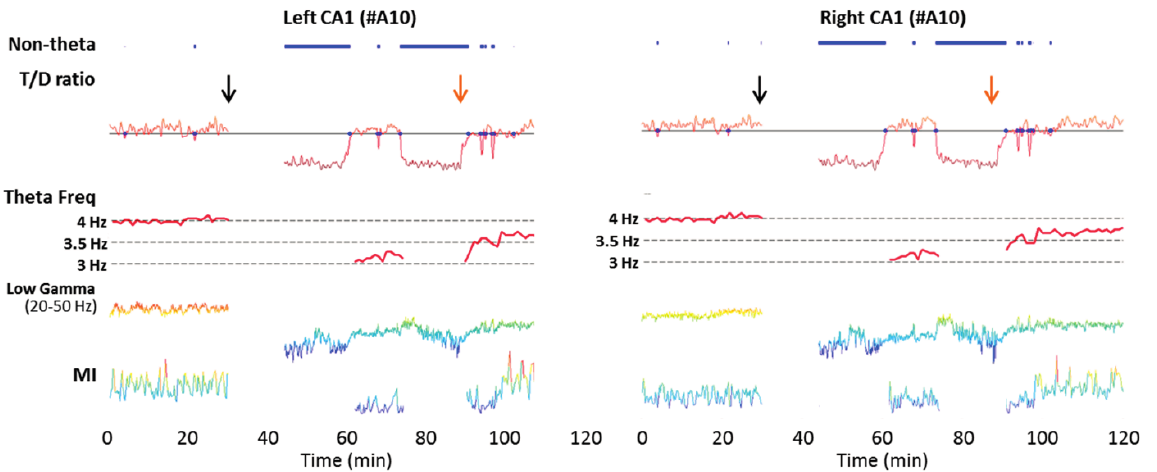
Figure 2. Acute cortical ischemia induces a reduction in the hippocampal θ frequency and the θ / δ ratio. Extracellular recordings were performed using multisite silicon probes (A1X16-5mm-100-703, NeuroNexus Technologies) under urethane anesthesia for 2 h. Data from the channel located at the stratum lacunosum moleculare were used for the analysis based on the high signal-to-noise ratio of θ and low- γ oscillations at the molecular layer compared to other hippocampal layers. Experimental stroke was induced by a permanent occlusion of the left, distal MCA and temporary occlusion of the bilateral common carotid arteries (CCAs) for 60 min. An immediate transition to slow-wave sleep from θ state occurred after MCAO, followed by the return of the θ state after reperfusion. Reductions in θ frequency, θ / δ (T/D) ratio, and modulation index between θ and low γ (MI Low γ ) and a decrease in low γ power were evident during some periods of occlusion and reperfusion. MI was computed based on Tort et al ., (2010) with the band-pass filter set at 20–50 Hz [211], corresponding to the low- γ power modulated by the θ phase. Color: relative values of low- γ power or modulation index (warmer color reflects larger value). Black arrows: stroke onset at 30 min; orange arrows: start of the reperfusion of the bilateral common carotid arteries at 60 min after stroke. Blue line: Non-theta periods. Note: recording of the initial period after MCAO was temporarily interrupted due to ischemic